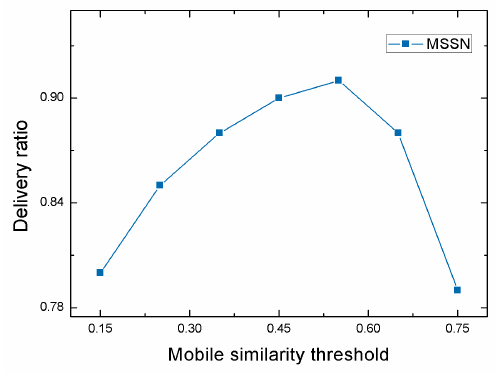
Figure 5. Delivery ratio with various mobile similarity threshold.